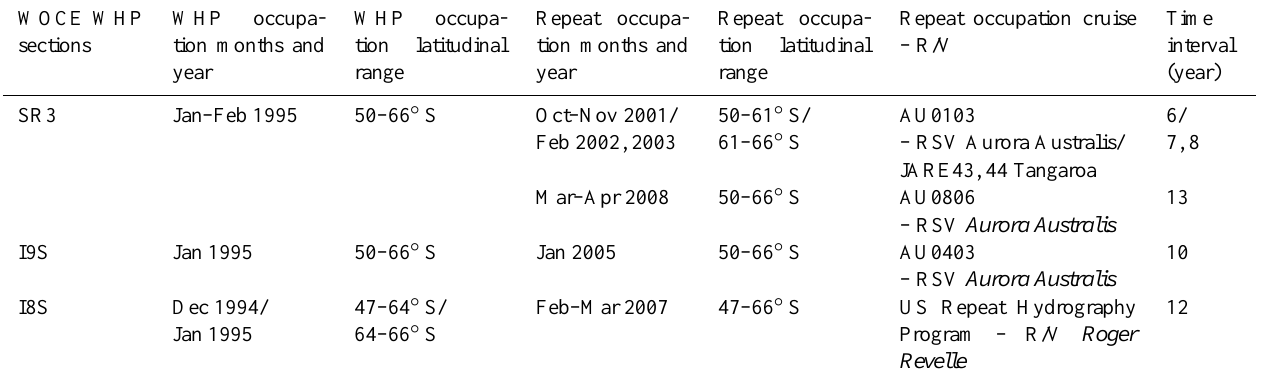
Table 1. Summary of the WOCE WHP and repeat occupations. The WOCE WHP section designation, years and months and latitudinal range of the WHP and repeat occupations, cruise code names, vessels used for repeat occupations and time intervals. WOCE